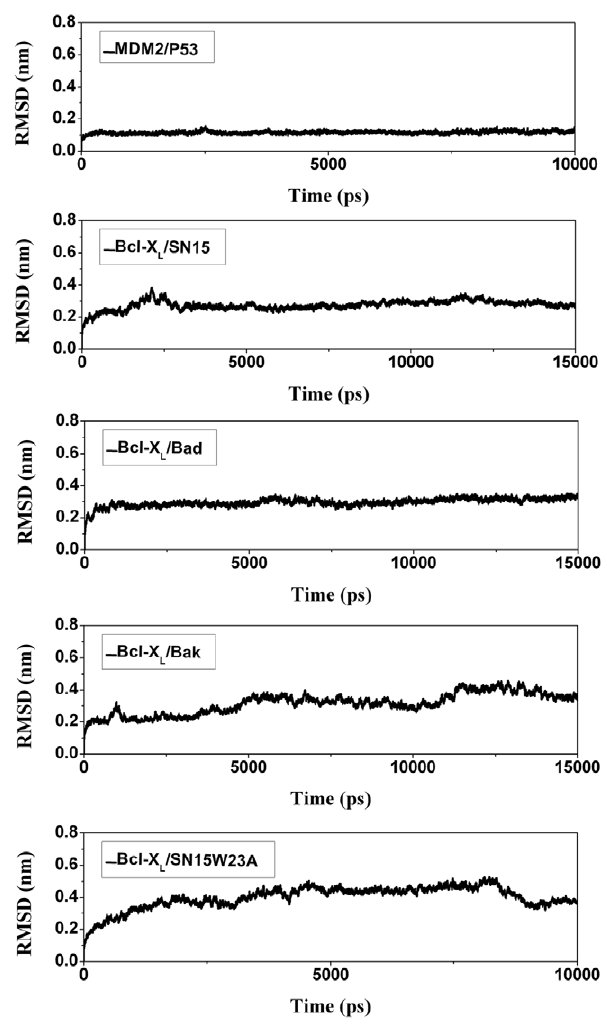
Figure 2. RMSD plots for five MD simulations. The Root mean square deviation (RMSD) of backbone atoms were shown with respect to initial minimized structure for all the five simulations such as MDM2/ p53 (A), Bcl-X L /SN15 (B), Bcl-X L /Bad (C), Bcl-X L /Bak (D), and Bcl-X L / SN15W23A (E).